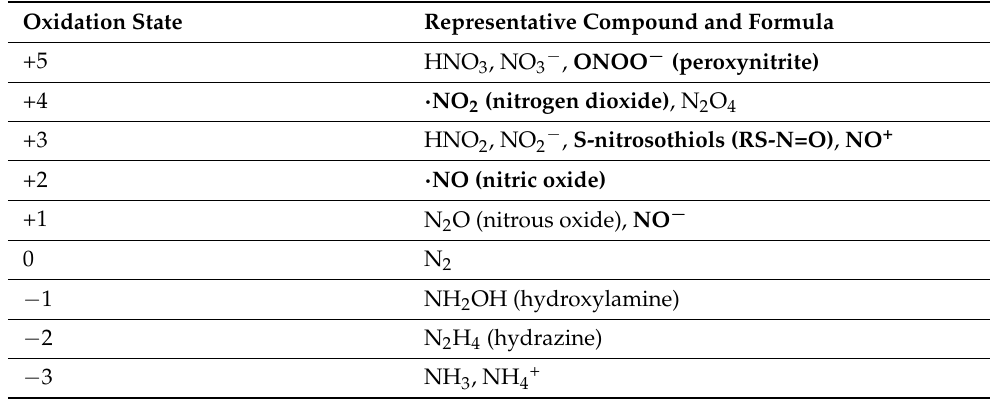
Table 2. Representative nitrogen compounds and their oxidation state. RNS are in bold letters. Oxidation